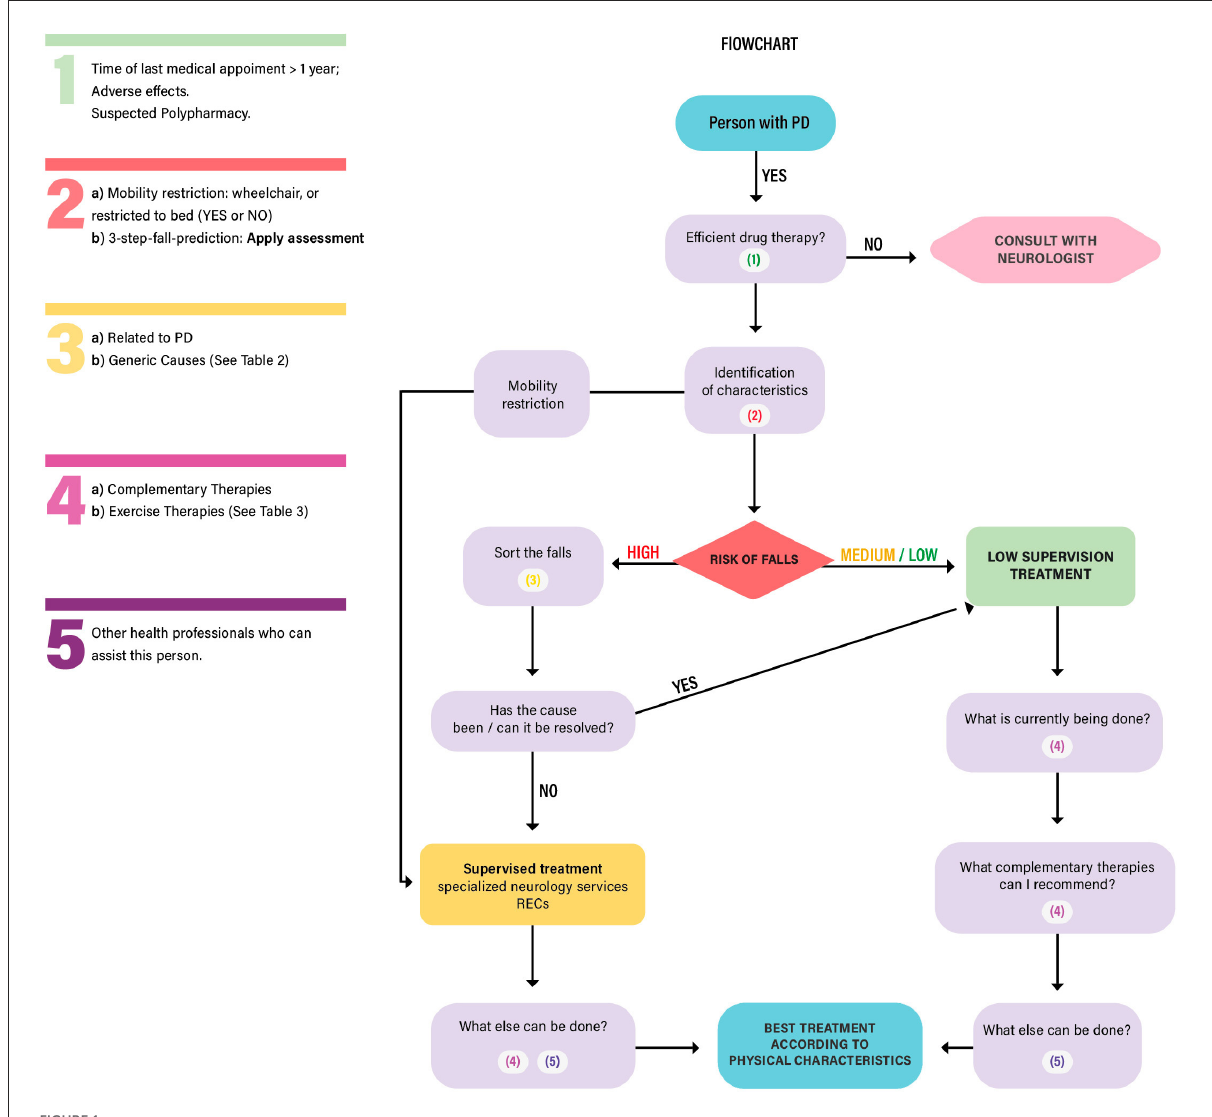
FIGURE1 Elaborated by the authors. RECs: Specialized Rehabilitation Centers. PD: Parkinson’s